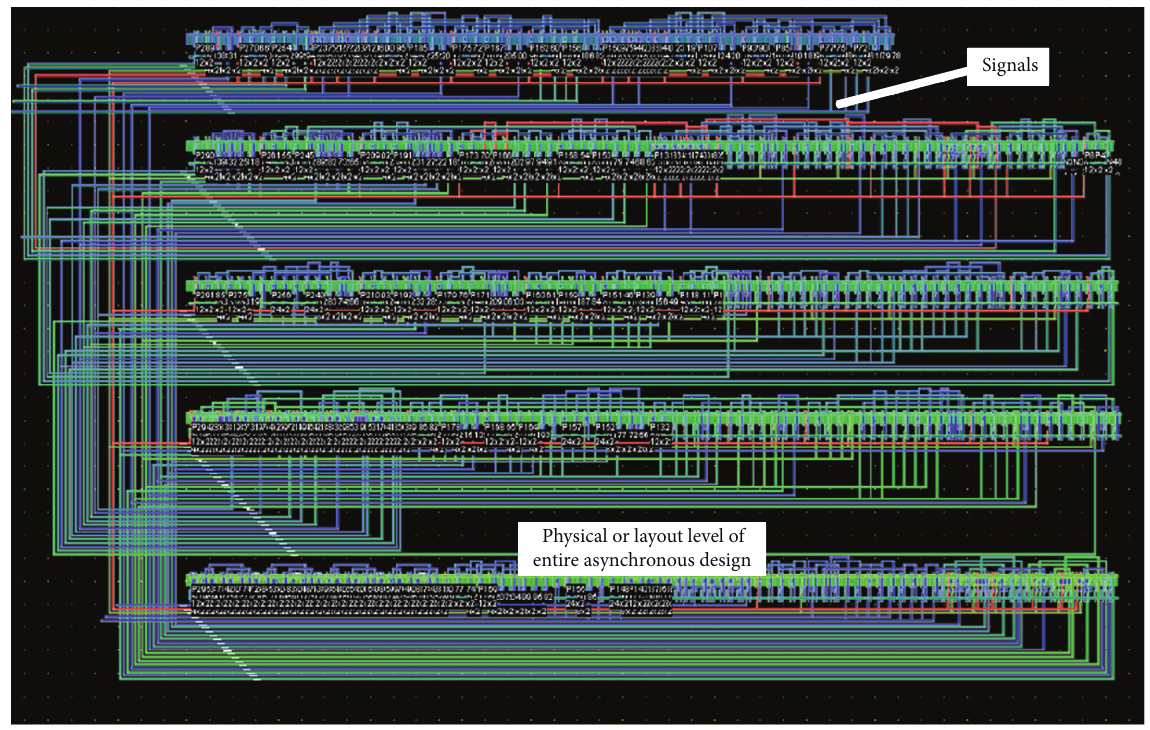
Figure 14: Layout of asynchronous Viterbi